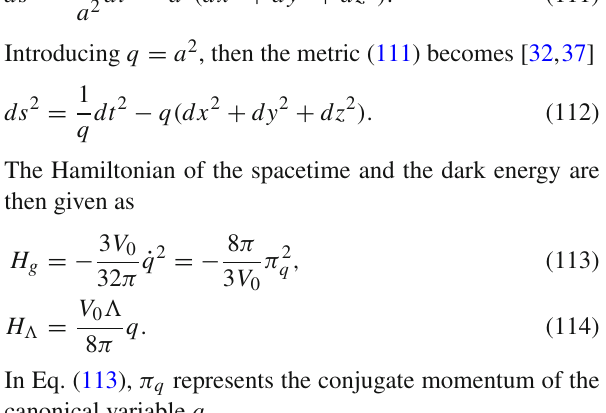
have the similar trend with the variations of the